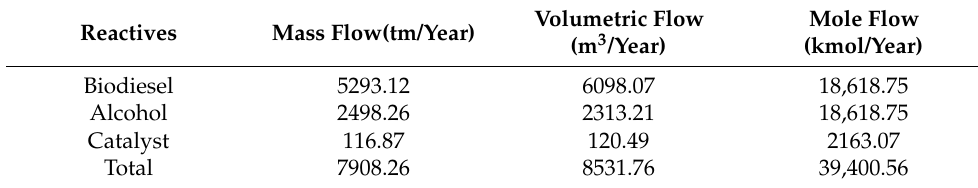
Table 5. Flows at the inlet of the